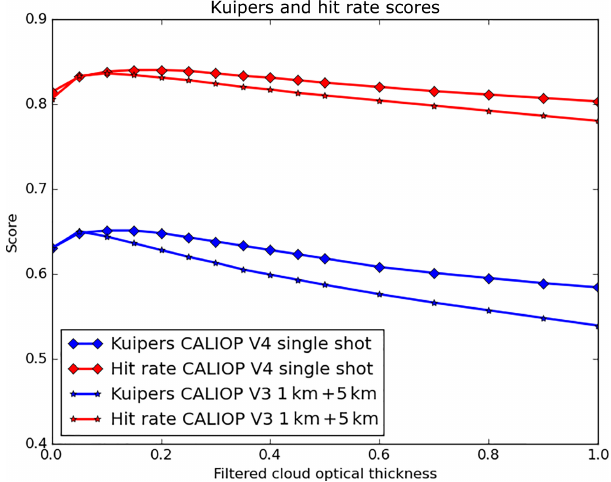
Figure 6. Global estimation of the probability of detecting a cloud with a certain cloud optical thickness. Calculations are based on all available AVHRR-CALIOP matchups over the time period Octo- ber 2006 to December 2015.